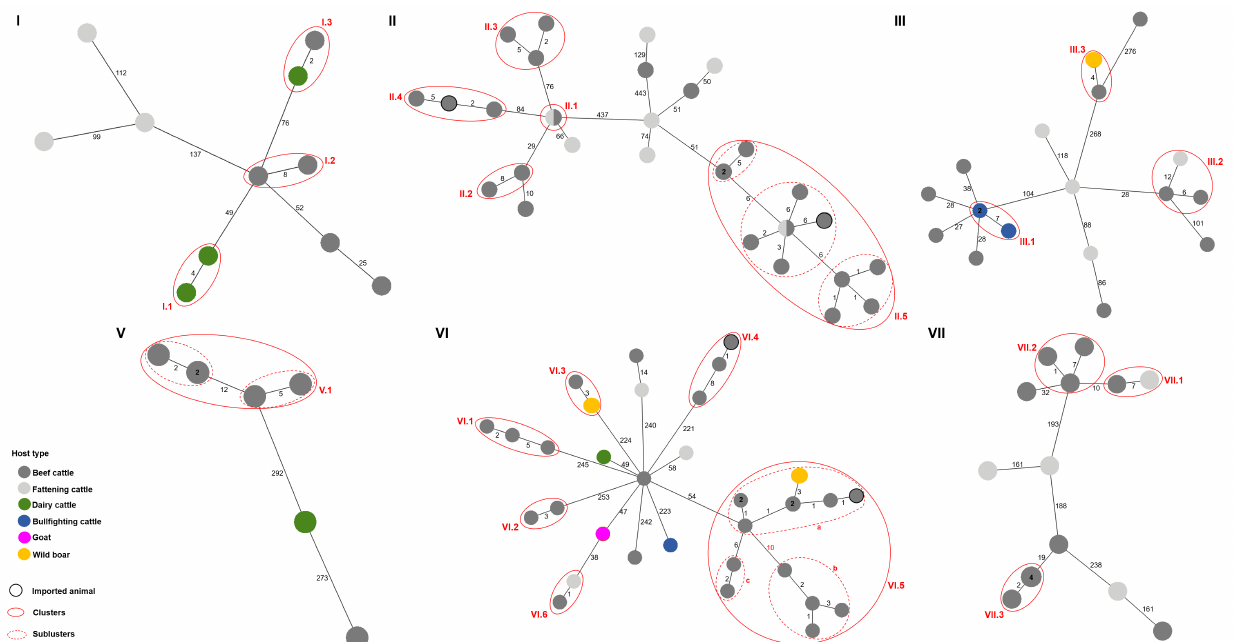
Figure 3. Minimum spanning trees (MSTs) of the putative transmission clusters identified within the main WGS clades (I–III and V–VII) based on SNP analysis of 125 M. bovis isolates obtained in Catalonia, Spain, from 2008 to 2018. Nodes are colored according to host type. Clusters (solid red circles) and subclusters (dashed red circles) are identified. The nodes that have a black outline represent cattle imported into Catalonia from outside of Spain. Numbers inside nodes indicate the total number of isolates represented by that node. The numbers on the branches connecting the nodes represent the number of segregating SNP sites between a pair of nodes. MSTs were constructed using the whole-genome concatenated SNP sequences for each main clade and PHYLOViZ2.0 (https://online.phyloviz.net/index, accessed on 29 July 2021).